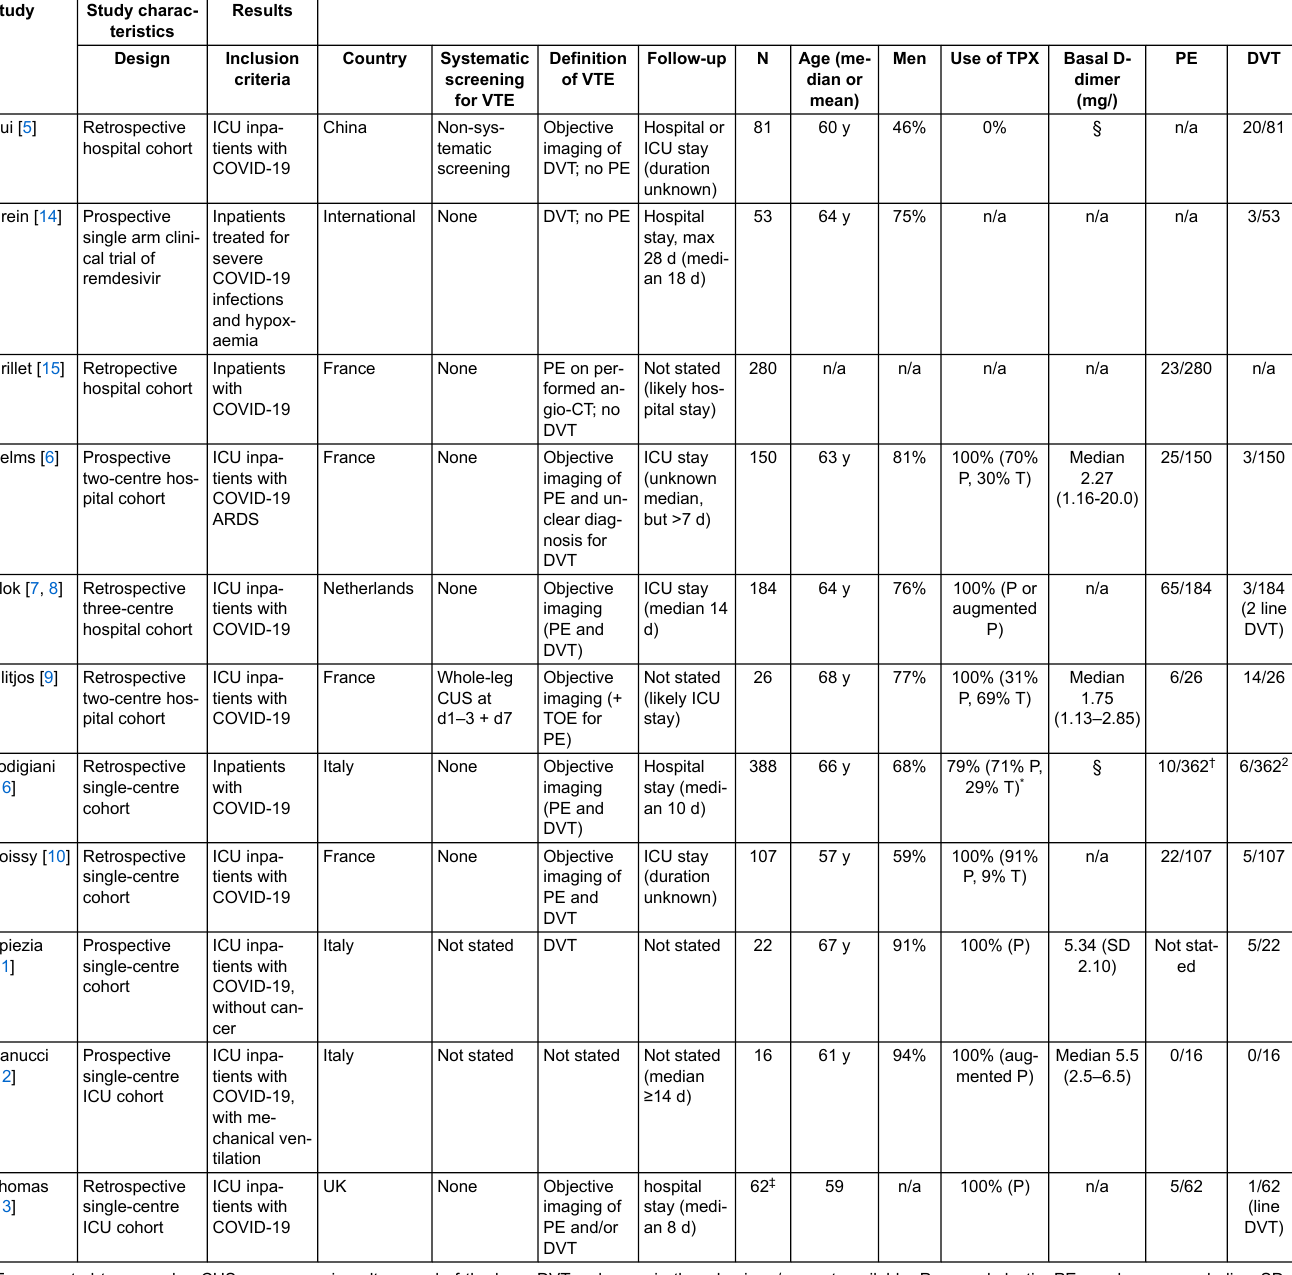
Table 1: Characteristics and findings of the studies reporting the risk of venous thromboembolism in COVID-19